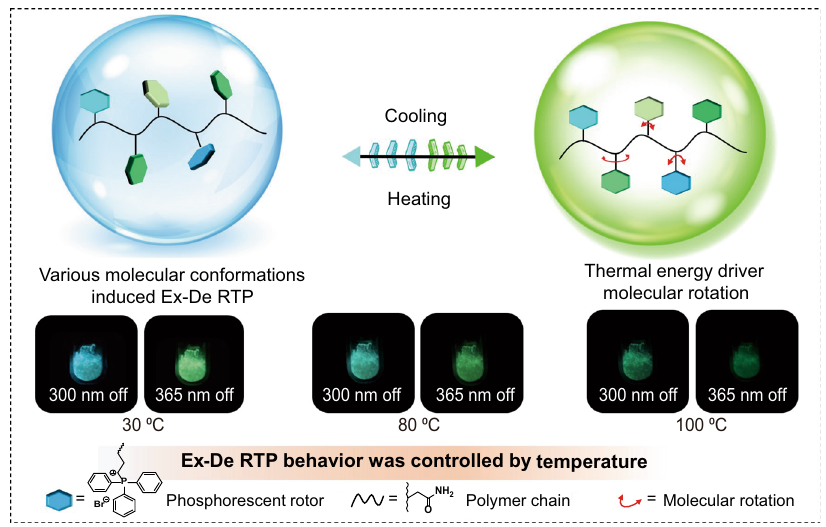
Fig.1|SchematicrepresentationforthedynamicmanipulationofEx-DeRTPbehavior. TheEx-DeRTPpropertyisoriginatedfromvariousmolecularconformationsof monomers, and the Ex-De RTP behavior can be controlled by thermal